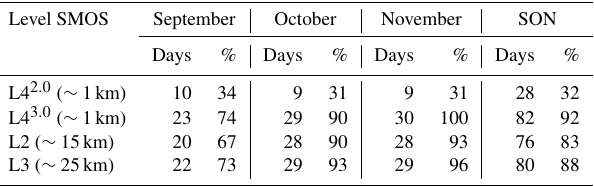
Table 2. Number of days (percentage) in which the SMOS (ascend- ing and descending swaths) coverage is higher than